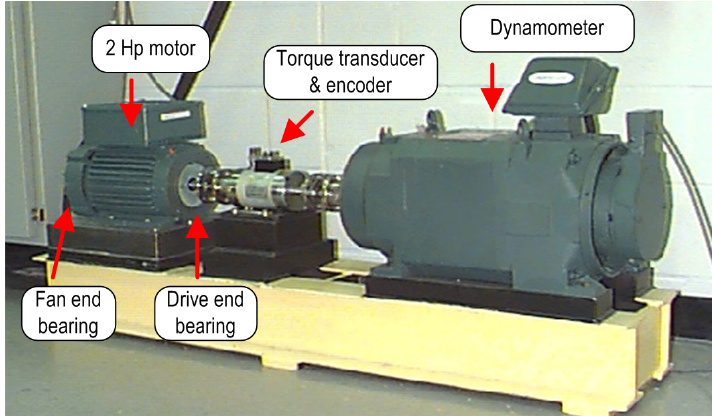
Figure 4. Experimental data acquisition system workbench by